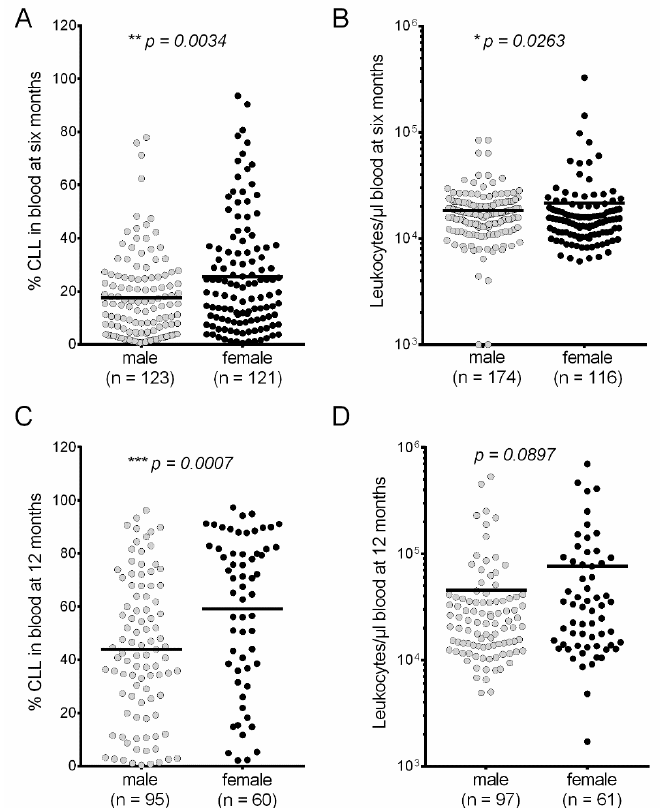
Figure 1. Significant sex difference in chronic lymphocytic leukemia (CLL) progression in the E µ -TCL1 tg / wt mice. ( A ) Significantly lower CLL load in the peripheral blood of males compared to females at six months. Blood samples from tail vein were assessed by flow cytometry to determine the CD5-positive CLL percentage in lymphocytes. Males: n = 123; Mean ± SEM: 17.55% ± 1.435%. Females: n = 121; Mean ± SEM: 25.43% ± 1.953%. Mann–Whitney test: ** p = 0.0034. ( B ) Lower leukocyte count in the peripheral blood (cells per µ L) in male than female E µ -TCL1 tg / wt mice at six months. Males: n = 174; Mean ± SEM: 18,420 ± 821.3; Females: n = 116; Mean ± SEM: 21,556 ± 3112; compared to females at 12 months. Males: n = 95; Mean ± SEM: 43.87% ± 2.758%. Females: n = 60; Mean ± SEM: 59.24% ± 3.701%. Mann–Whitney test: *** p = 0.0007. ( D ) Lower leukocyte count in the peripheral blood (cells per µ L) in male than female E µ -TCL1 tg / wt mice at 12 months. Males: n = 97; Mean ± SEM: 45,581 ± 8,089; Females: n = 61; Mean ± SEM: 76,442 ± 16,062; Mann–Whitney test: p =